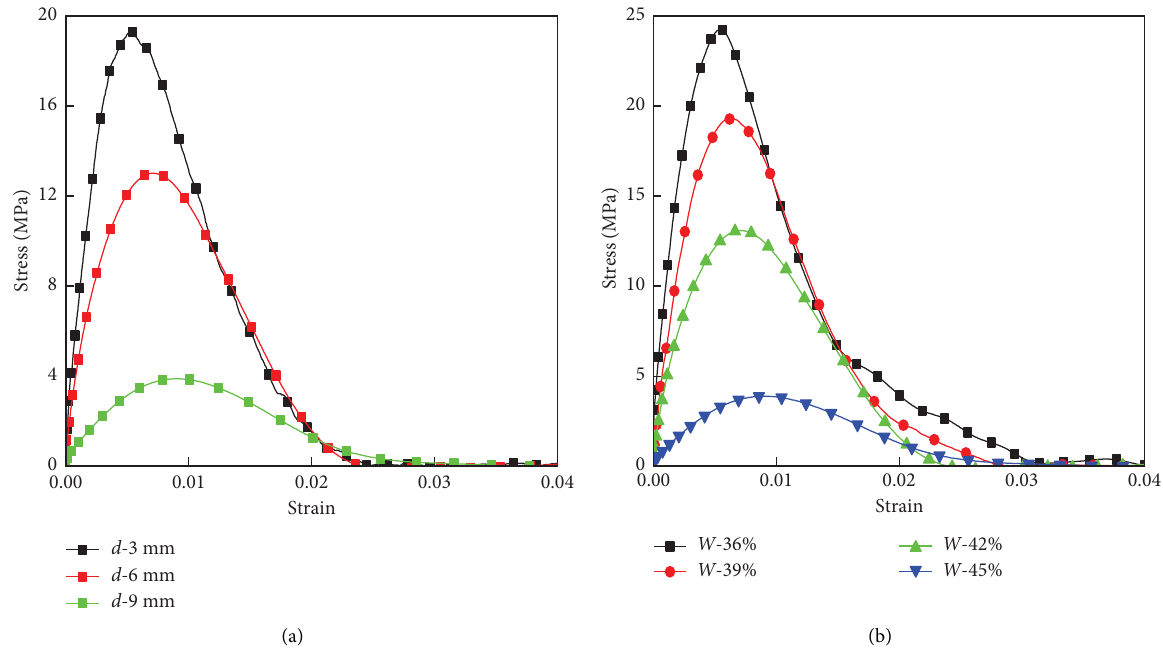
Figure 7: Dynamic stress-strain curve of the composite specimen. (a) W is the stress-strain curve of the composite specimen at 45%. (b) d is the stress-strain curve of the composite specimen under